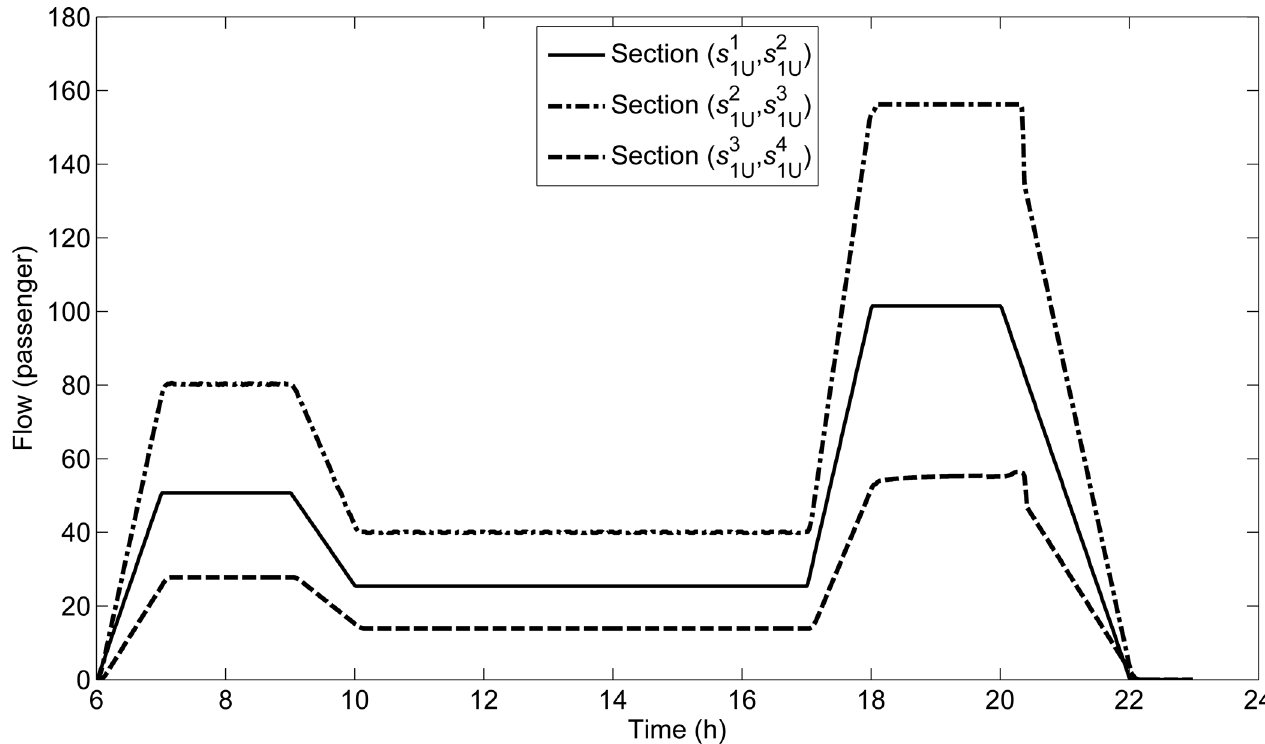
Fig 6. Section flows along L 1U